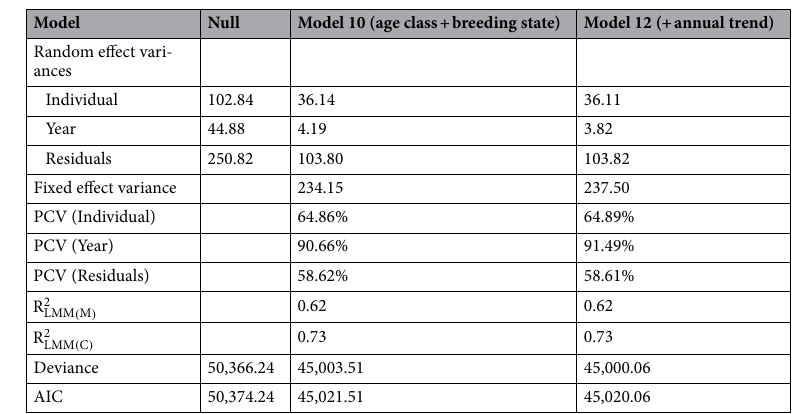
Table 2. Variance partitioning of selected linear mixed-effects models of the variation in moult arrival dates of female southern elephant seals at Marion Island (1986–2018). The random effect variance shows the partitioning of variance among random effects as well as the residual variance. The fixed effect variance shows the amount of variance that has been transferred from the random components to the fixed effects. The PCV (proportion change in variance) indicates how the inclusion of fixed effects has reduced (or when PCV is negative, increased) the variance of each random effect. For the individual random effect, PCV is the percentage of between-individual variance in moult arrival dates explained by covariates. For the year random effect, PCV is the percentage between-year variance in moult arrival dates explained by covariates. The R 2 R 2 LMM ( M ) value quantifies the amount of variance explained by fixed factors and LMM ( C ) value quantifies the amount of variation explained by both fixed and random factors.